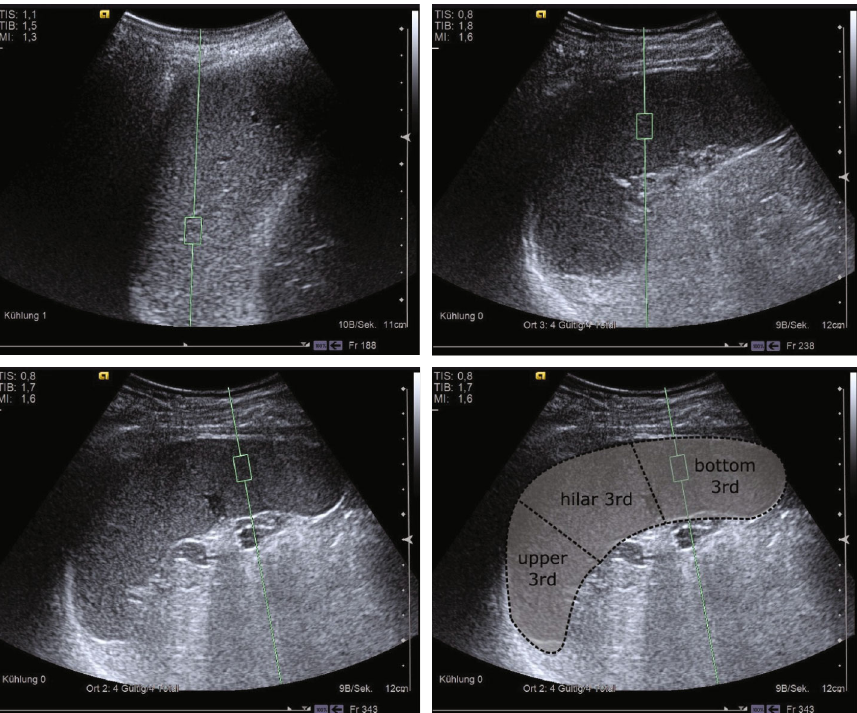
Figure 4: Considering signi fi cant variability of spleen sti ff ness results across the spleen, repetitive spleen sti ff ness measurements (SSM) were performed in three di ff erent sections of the spleen in the baseline and follow-up visits and respective delta results were calculated for every third of the spleen. The ARFI results were assessed in the upper, the hilar, and the bottom section (schematic image of the three spleen sections separated from each other) (ARFI =acoustic radiation force impulse imaging; SSM =spleen sti ff ness